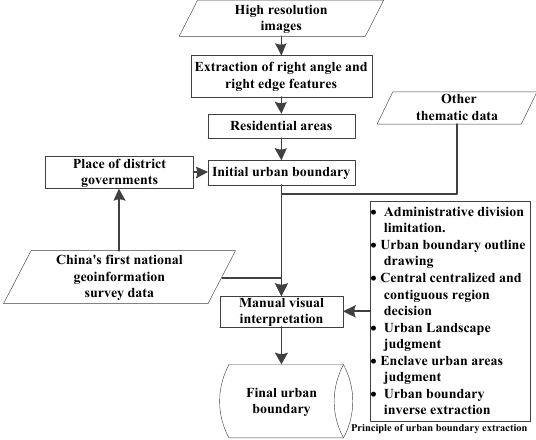
Figure 2. The workflow of urban boundary extraction